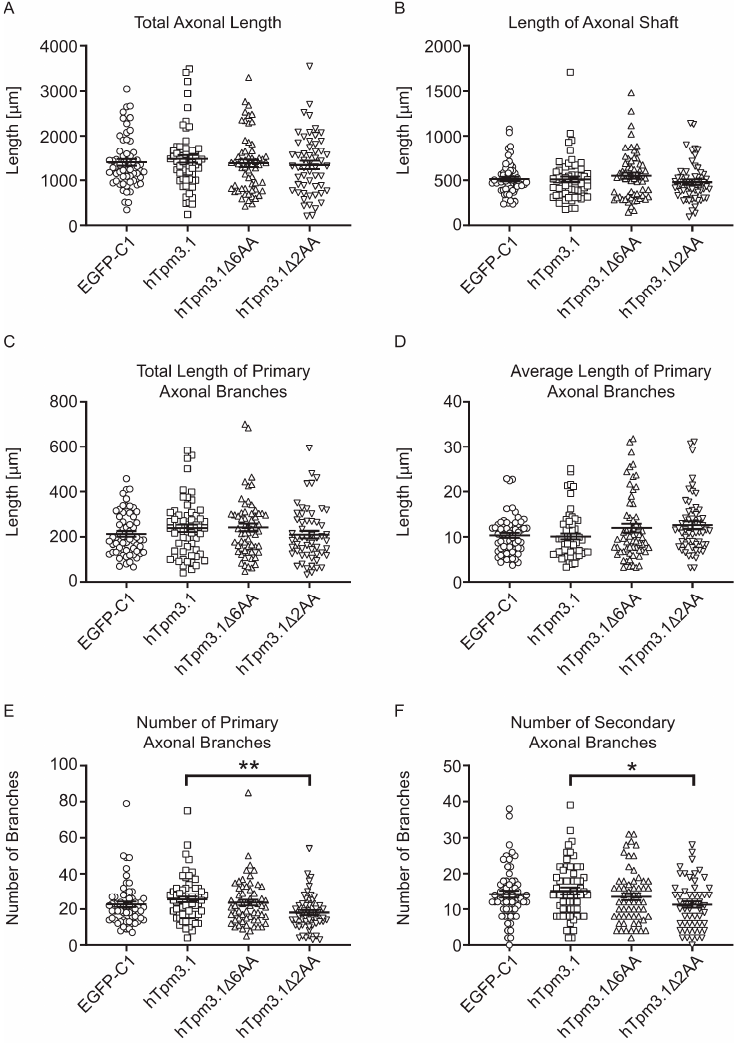
Figure 5. Quantitative analysis of axonal morphology of C57/Bl6 hippocampal neurons. Mouse primary hippocampal neurons expressed EGFP-C1, hTpm3.1, hTpm3.1 ∆ 6AA and hTpm3.1 ∆ 2AA for 48 h and were fixed at 4DIV. The analysed axonal morphological parameters are ( A ) total axonal length, ( B ) length of axonal shaft, ( C ) total length of primary axonal branches, ( D ) average length of primary axonal branches, ( E ) number of primary axonal branches, and ( F ) number of secondary axonal branches. In total, 55–60 neurons from three biological replicates (with at least 15 neurons per replicate) were analysed for each construct. Error bars represent standard error of the mean. Significance was determined by Kruskal–Wallis test with Dunn’s correction for multiple comparisons: * p < 0.05, ** p <